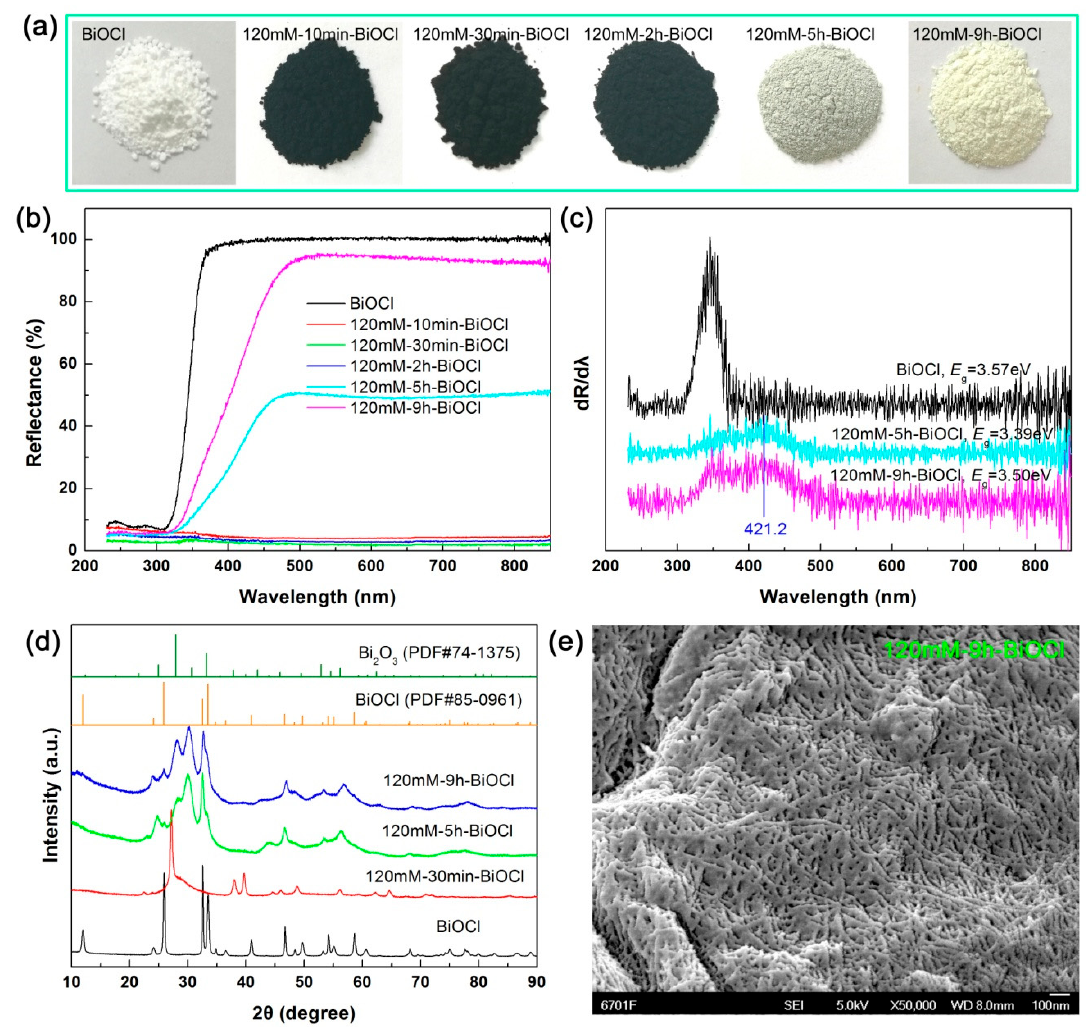
Figure 12. ( a ‒ d ) apparent colors, UV-vis diffuse reflectance spectra, first derivative curves of the UV- vis diffuse reflectance spectra, and XRD patterns of the 120 mM NaBH 4 -treated BiOCl samples with different treatment times, respectively. ( e ) SEM image of 120mM-9h-BiOCl.